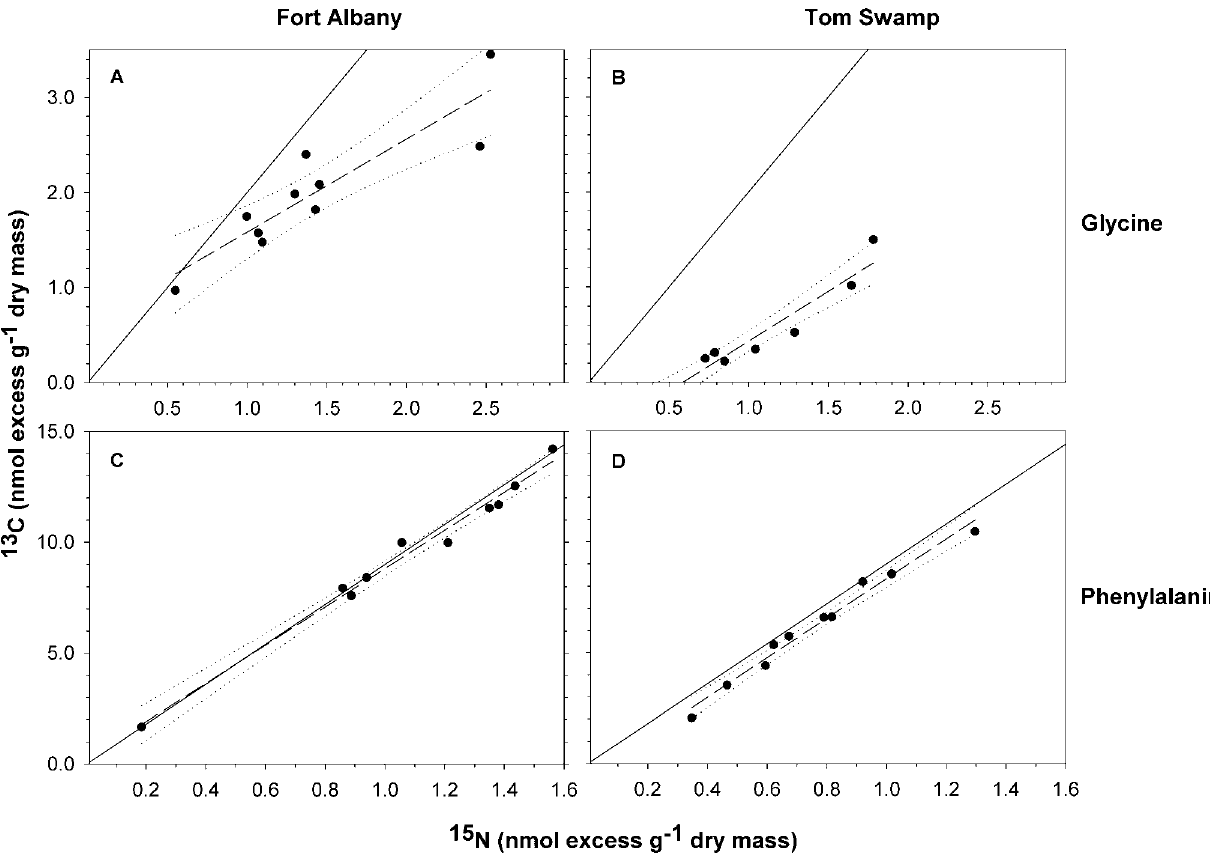
Figure 3. Concentration of 13 C and 15 N recovered in Sarraceniapurpurea pitchers 3 h after feeding. Nitrogen solutions were applied into the pitcher leaves at Fort Albany in Ontario, Canada (left, panels A, C ) and at Tom Swamp in Massachusetts, U S A (right, panels B, D ) as uniformly- labeled (U-) 13 C- 15 N-glycine (top row, panels A, B ) or as U- 13 C- 15 N-phenylalanine (bottom row, panels C, D ). Solid lines represent the 13 C: 15 N ratio of glycine (2:1) or phenylalanine (9:1); dashed-lines represent ordinary least squares regression (with 95% confidence intervals as dotted lines) for plant uptake.